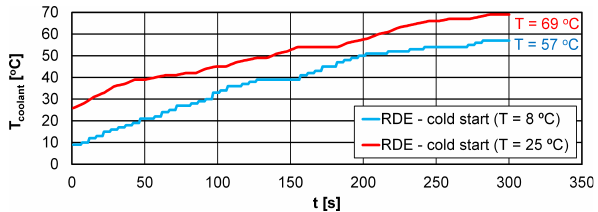
Figure 4: The coolant temperature after the cold start at different ambient temperatures